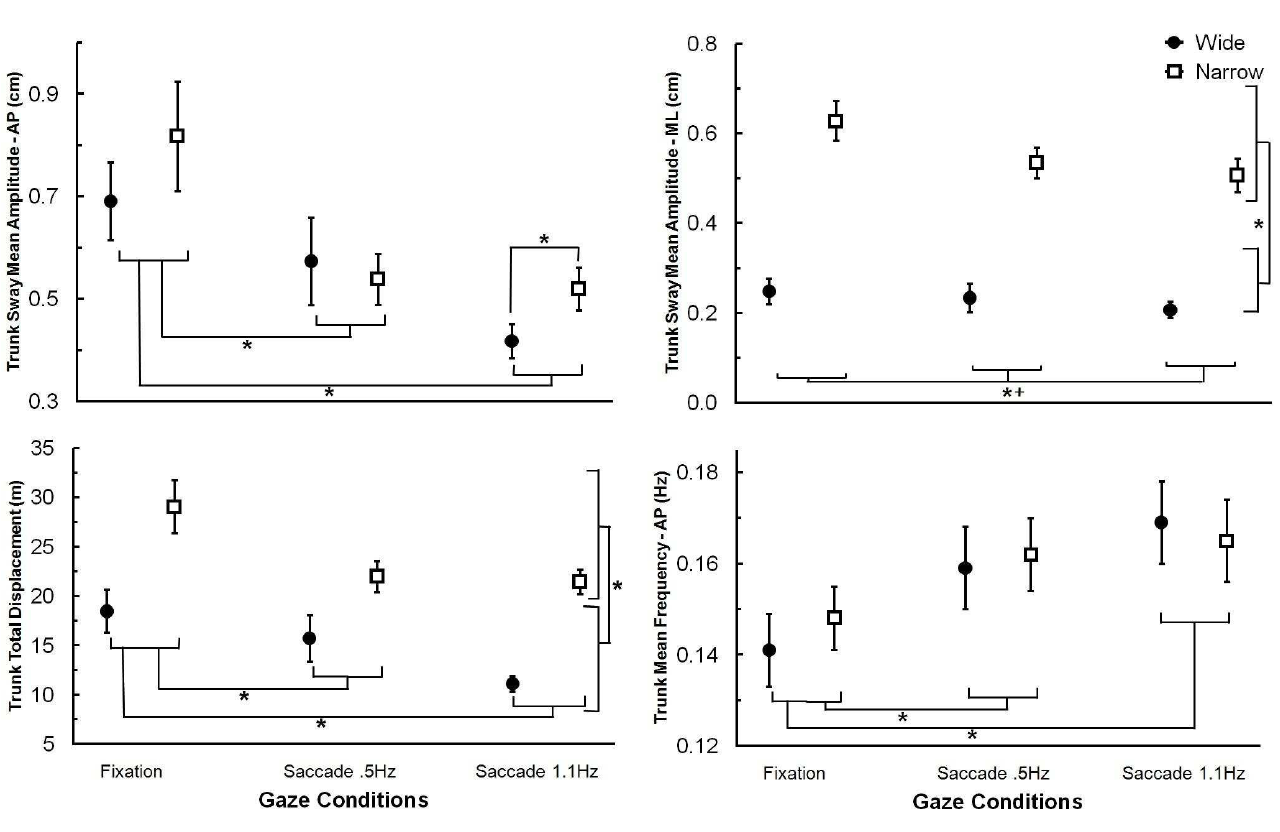
Figure 1. Mean and standard error of anterior-posterior (top left) and medial-lateral (top right) trunk sway mean amplitude, trunk total displacement (bottom left), and trunk mean frequency (bottom right) for the three gaze conditions (fixation, saccade 0.5 Hz, and saccade 1.1 Hz) and for the two stances (wide and narrow) * p < 0.05; + Post-hoc pairwise comparisons between gaze condtions were not